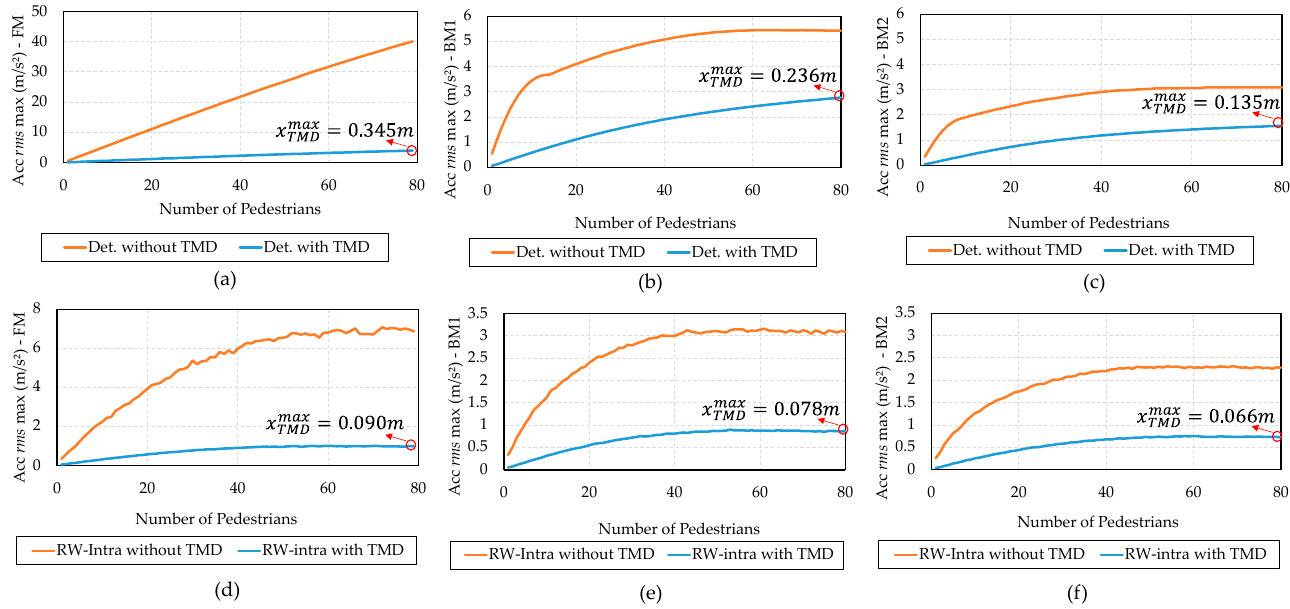
Figure 5. Acceleration amplitudes for the deterministic response ( a ) FM, ( b ) BM1, and ( c ) BM2, and for the RW-intra response ( d ) FM, ( e ) BM1, and ( f ) BM2.